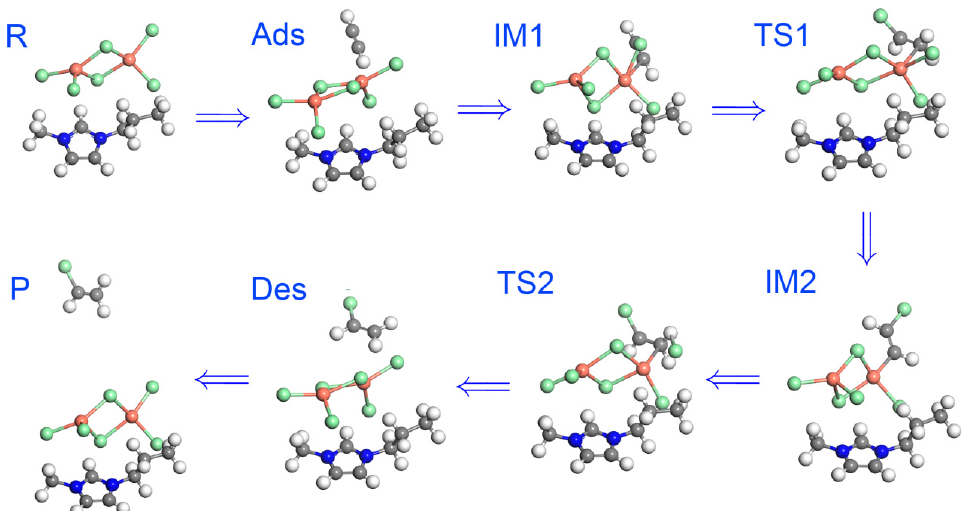
Figure 15. Reaction path of acetylene hydrochlorination near the Cu(II) atom, as catalyzed jointly by the catalyst CuCl 2 and the reaction media [PrMIm]Cl. Shown is the process in which the anion [Cu 2 Cl 6 ] 2 − participates in the catalysis. Here Cu exists in the form of [Cu 2 Cl 6 ] 2 − , and is adsorbed near the N atoms of [PrMIm]Cl. Here, brick red spheres denote Cu atoms, and the color coding for other atoms is the same as Figure 11.